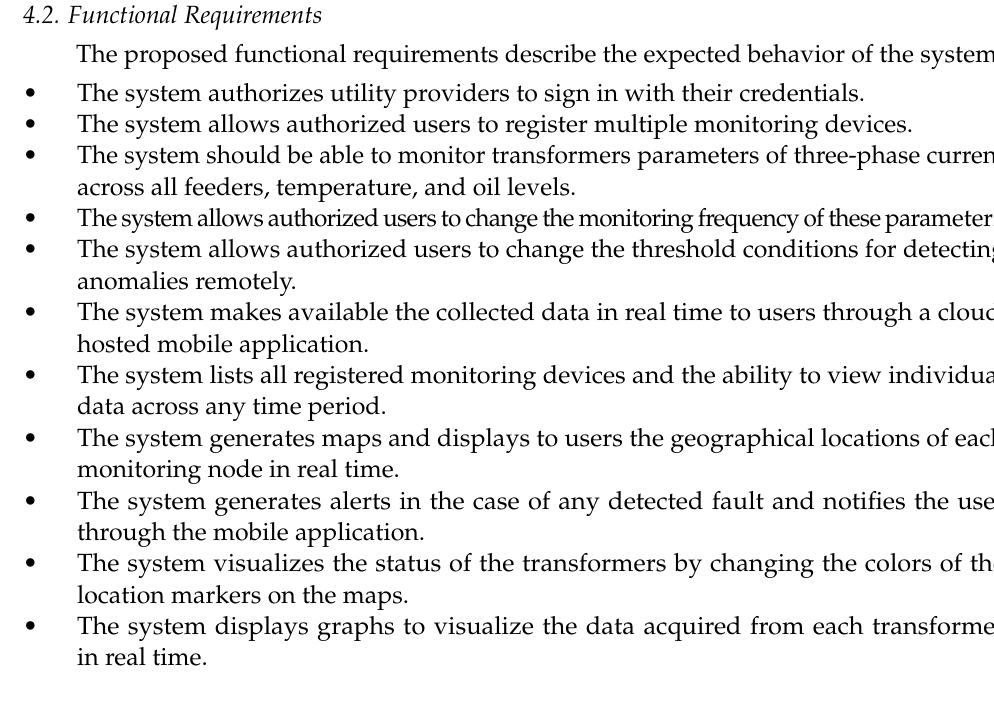
Figure 1. Feeder network system for one